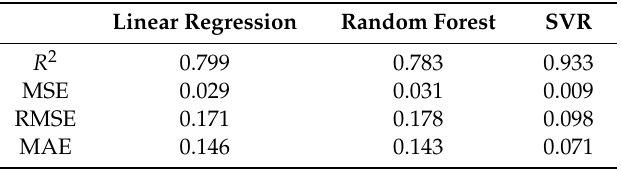
Table 3. Modeling Table 3. Modeling performance.